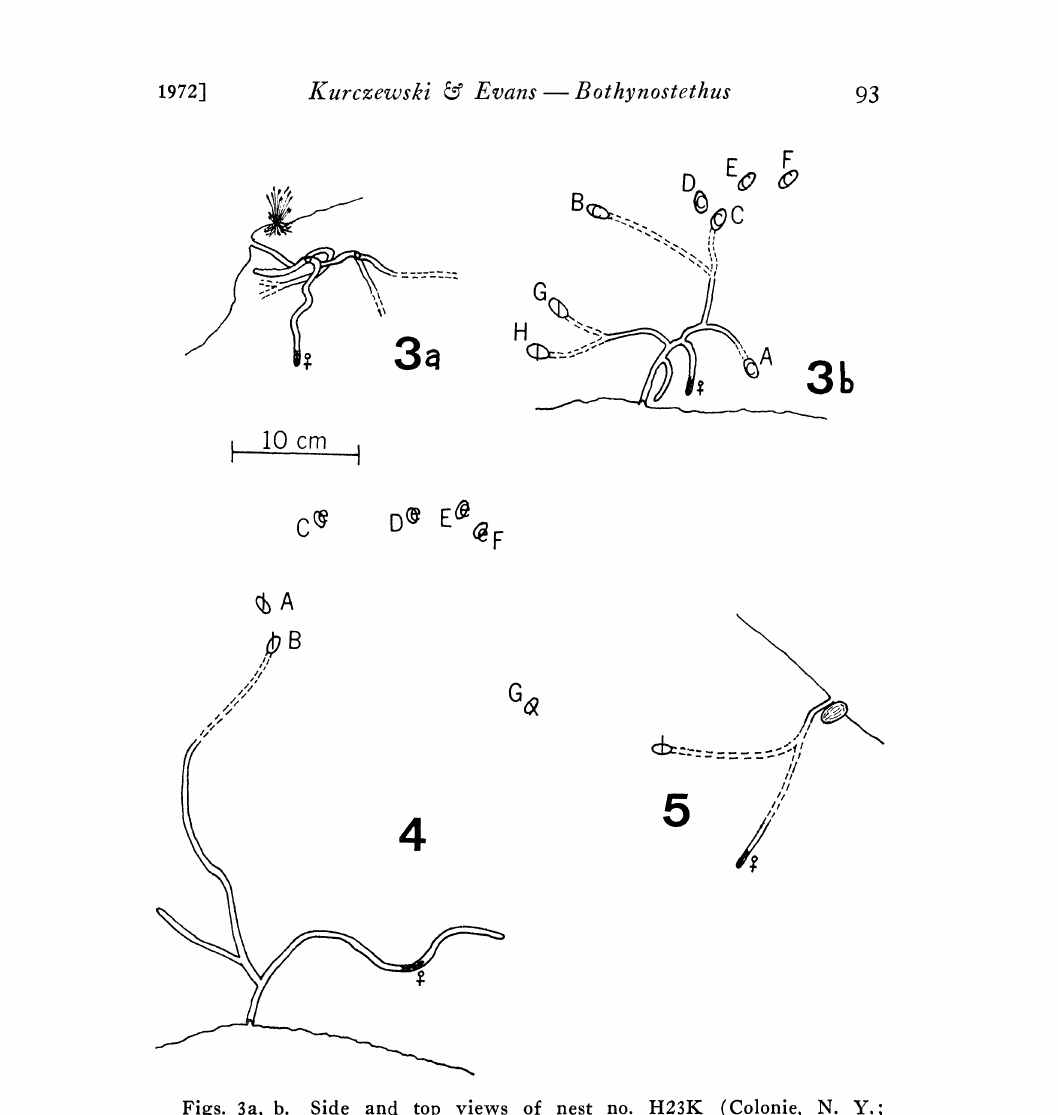
Figs. 3a, b. Side and top views of nest no. H23K (Colonie, N. Y.; 16 July 1970). Fig. 4. Top view of nest no. H23 (same locality; 7 July 1970). Fig. 5. Side view of nest no. 2306 (Bedford, Mass.; 23 Sept. 1971). Traceable burrows are indicated by solid lines, untraceable ones by dotted lines. Cells in Figs. 3b, 4 are lettered in apparent chronological order, according to contents. Cell contents are as follows: e, egg; 1, larva; e, cocoon; x, contents